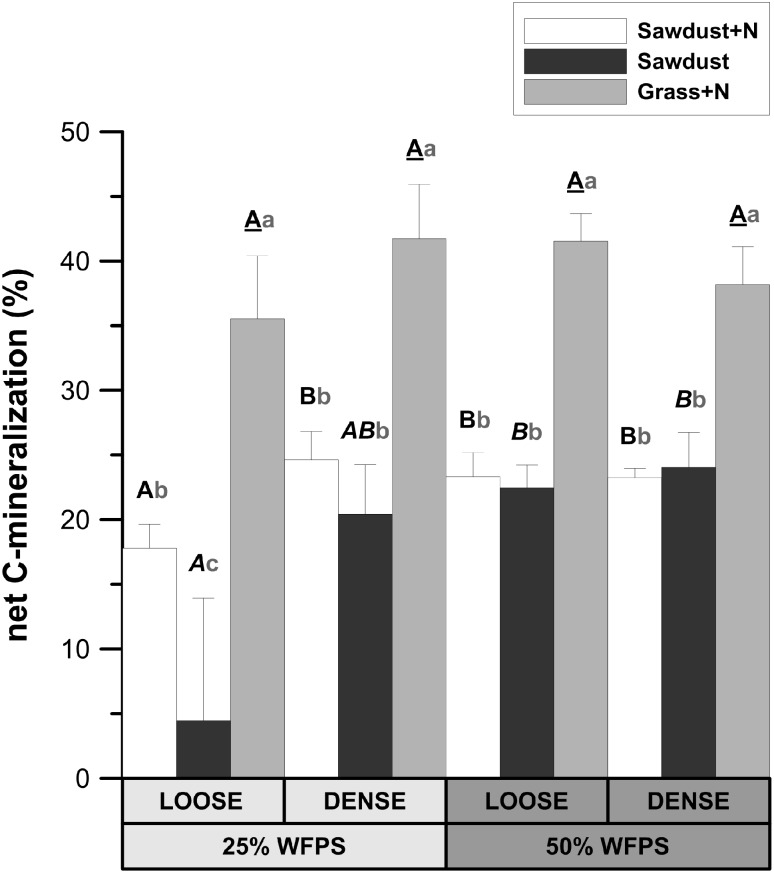
Relative fraction of plant substrate’s carbon mineralized after 128 days of incubation in soil cores at either 25 or 50% WFPS moisture level and with a ‘loose’ or ‘dense’ soil structure. Error bars represent standard deviations around means (n = 3). Statistically different structure and moisture treatments are indicated by different capital letters, one type per substrate+N treatment: bold letters for the sawdust+N treatment, bold italic letters for the sawdust treatment and underlined bold letters for the grass+N treatment. Statistically different substrate treatments within the same structure and moisture class combination are indicated by gray lowercase letters.